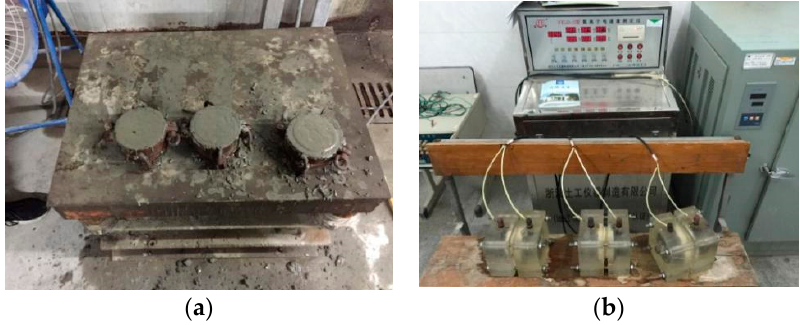
Figure 2. ( a ) Vibration forming and ( b ) test process of the specimens.